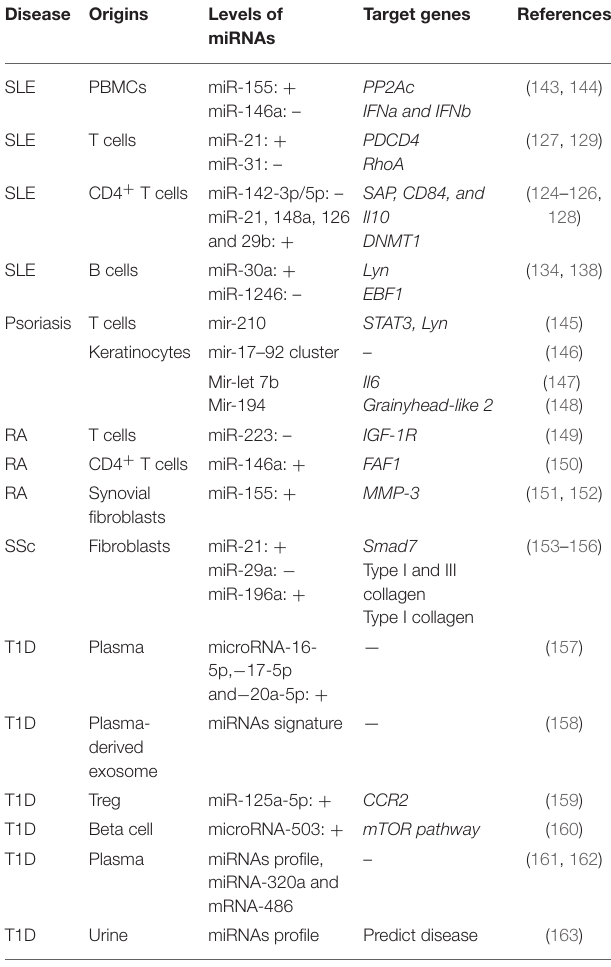
TABLE 2 | Dysregulated miRNA expressions in: SLE, Psoriasis, RA, SSc, and